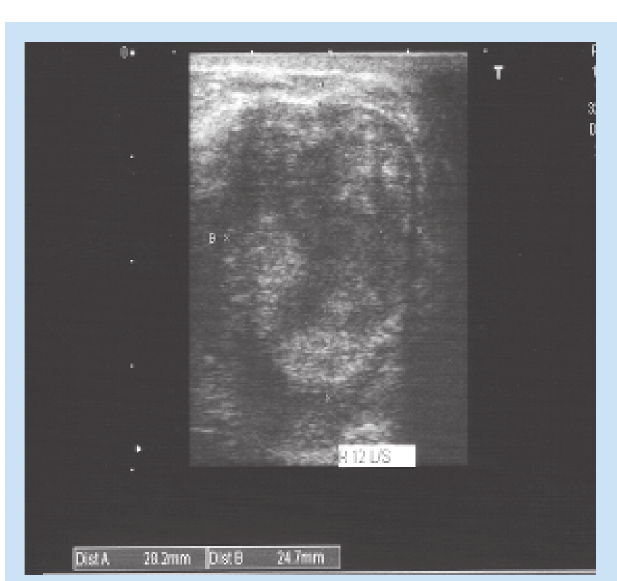
Fig. 2b. Case 2: High-frequency linear ultrasound of lesion in right breast – longitudinal section.